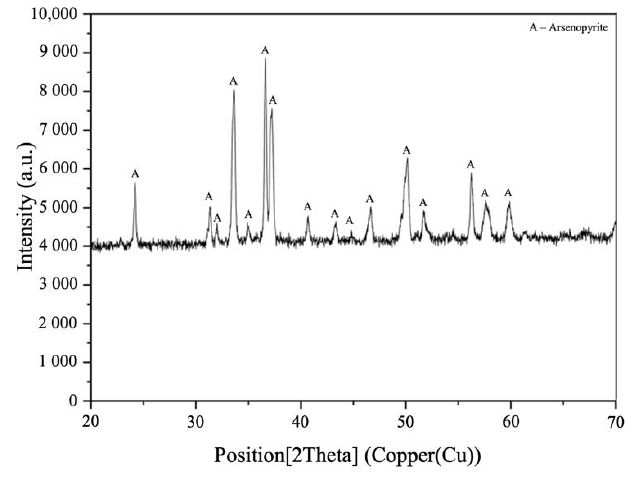
Figure 2. XRD pattern of the initial FeAsS particles (10 –29 μm). The particle size analysis of the ground mineral is shown in Table 1. Table 1. Particle size analysis .